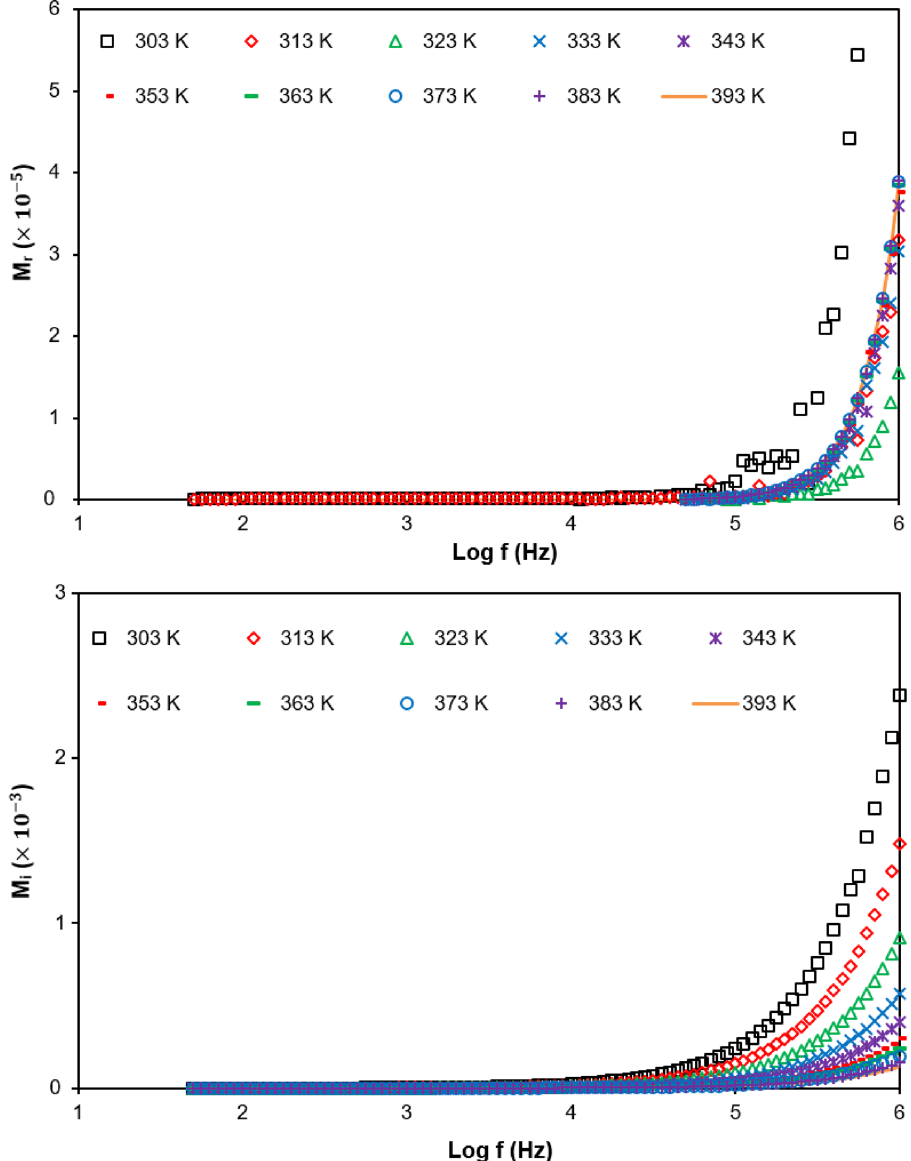
Figure 10. Real and imaginary modulus at various temperatures for PUA-30 wt% TBAI-I 2 GPE.